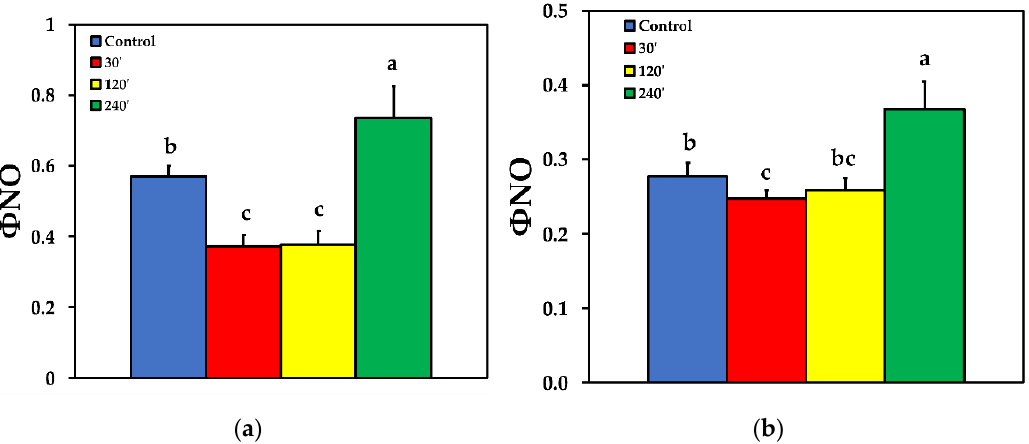
Figure 4. The quantum yield of non-regulated energy loss in PSII ( Φ NO ) before (control) and after 30, 120 and 240 min of B. cinerea aquatic spore suspension application on tomato leaflets, measured at 230 µ mol photons m − 2 s − 1 ( a ), and at 900 µ mol photons m − 2 s − 1 ( b ). Error bars are standard deviations (n = 6). Columns with different letters are statistically different ( p < 0.05).